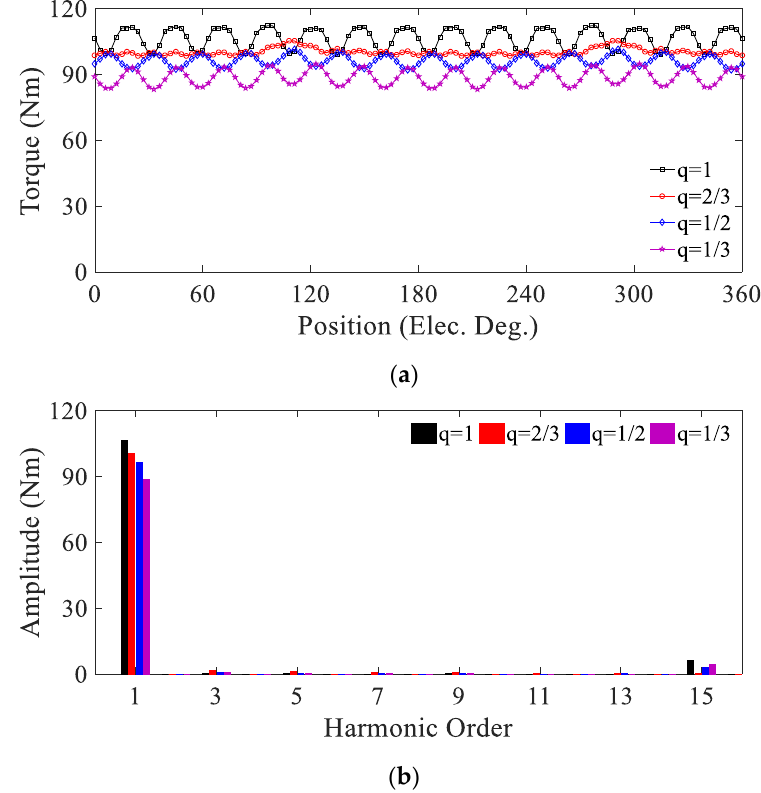
Figure 9. Initial models: ( a ) Average torque, ( b ) Torque FFT analysis.